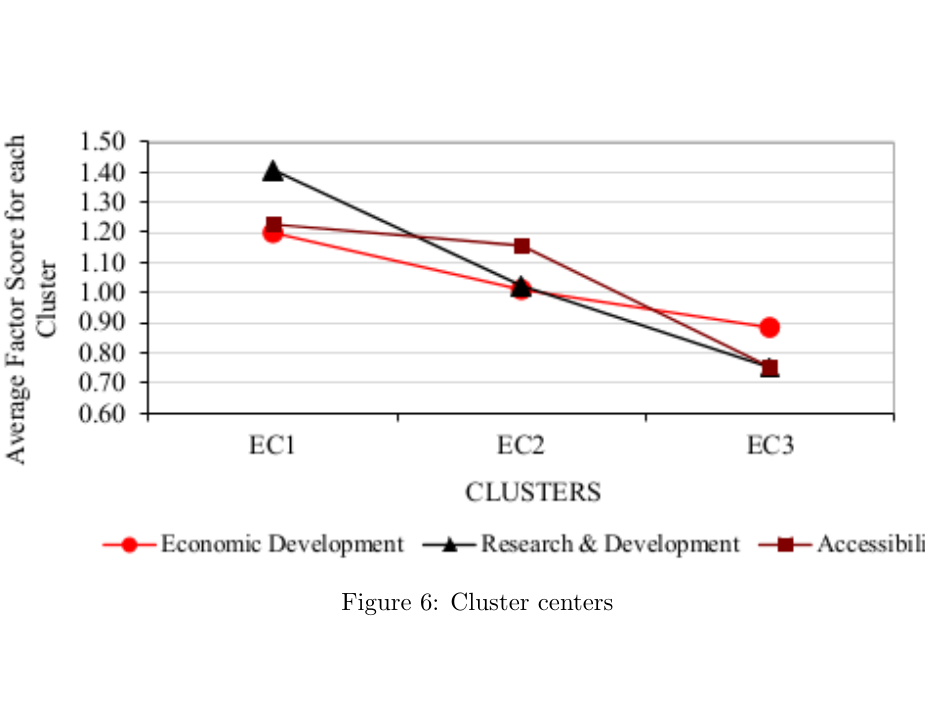
Figure 6: Cluster centers